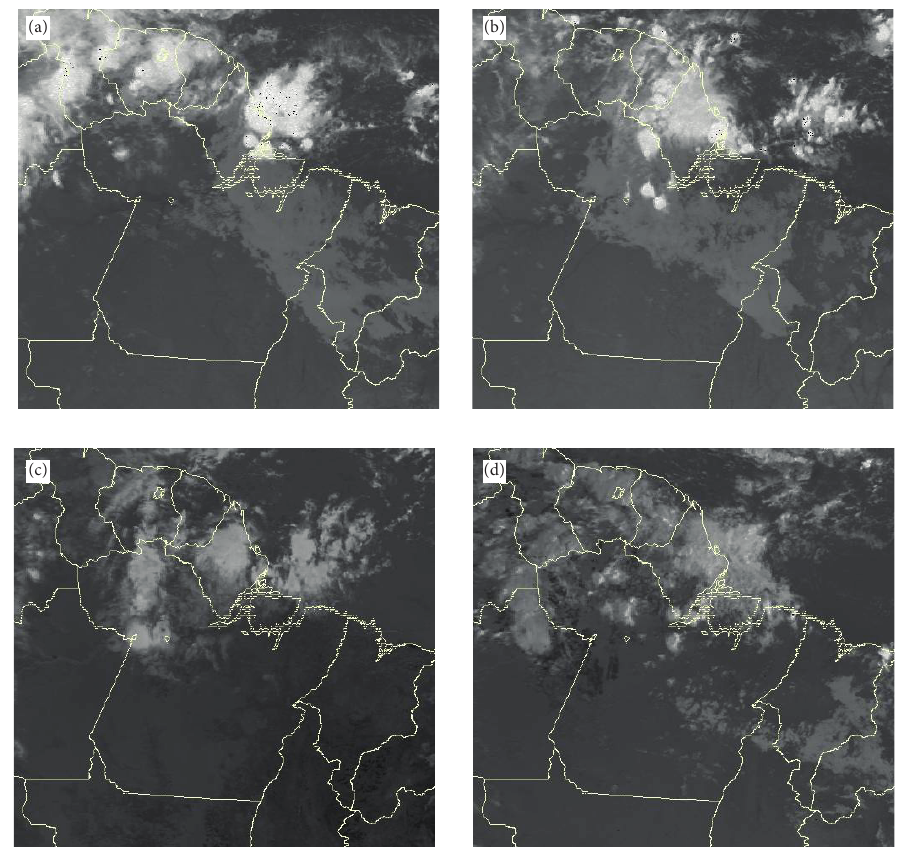
Figure 4. Satellite images for June 18 th , 2011 on IR channel at 00 (a), 08 (b), 14 (c), and 20 (d)